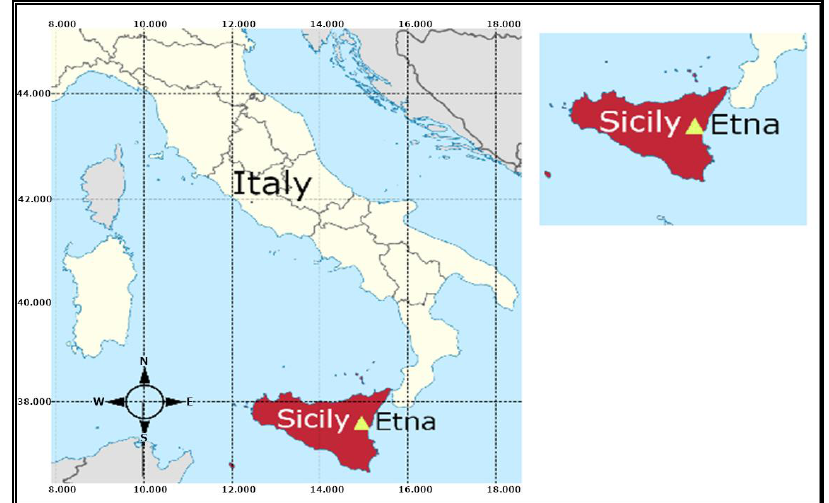
Figure 1. Location of Etna volcano.